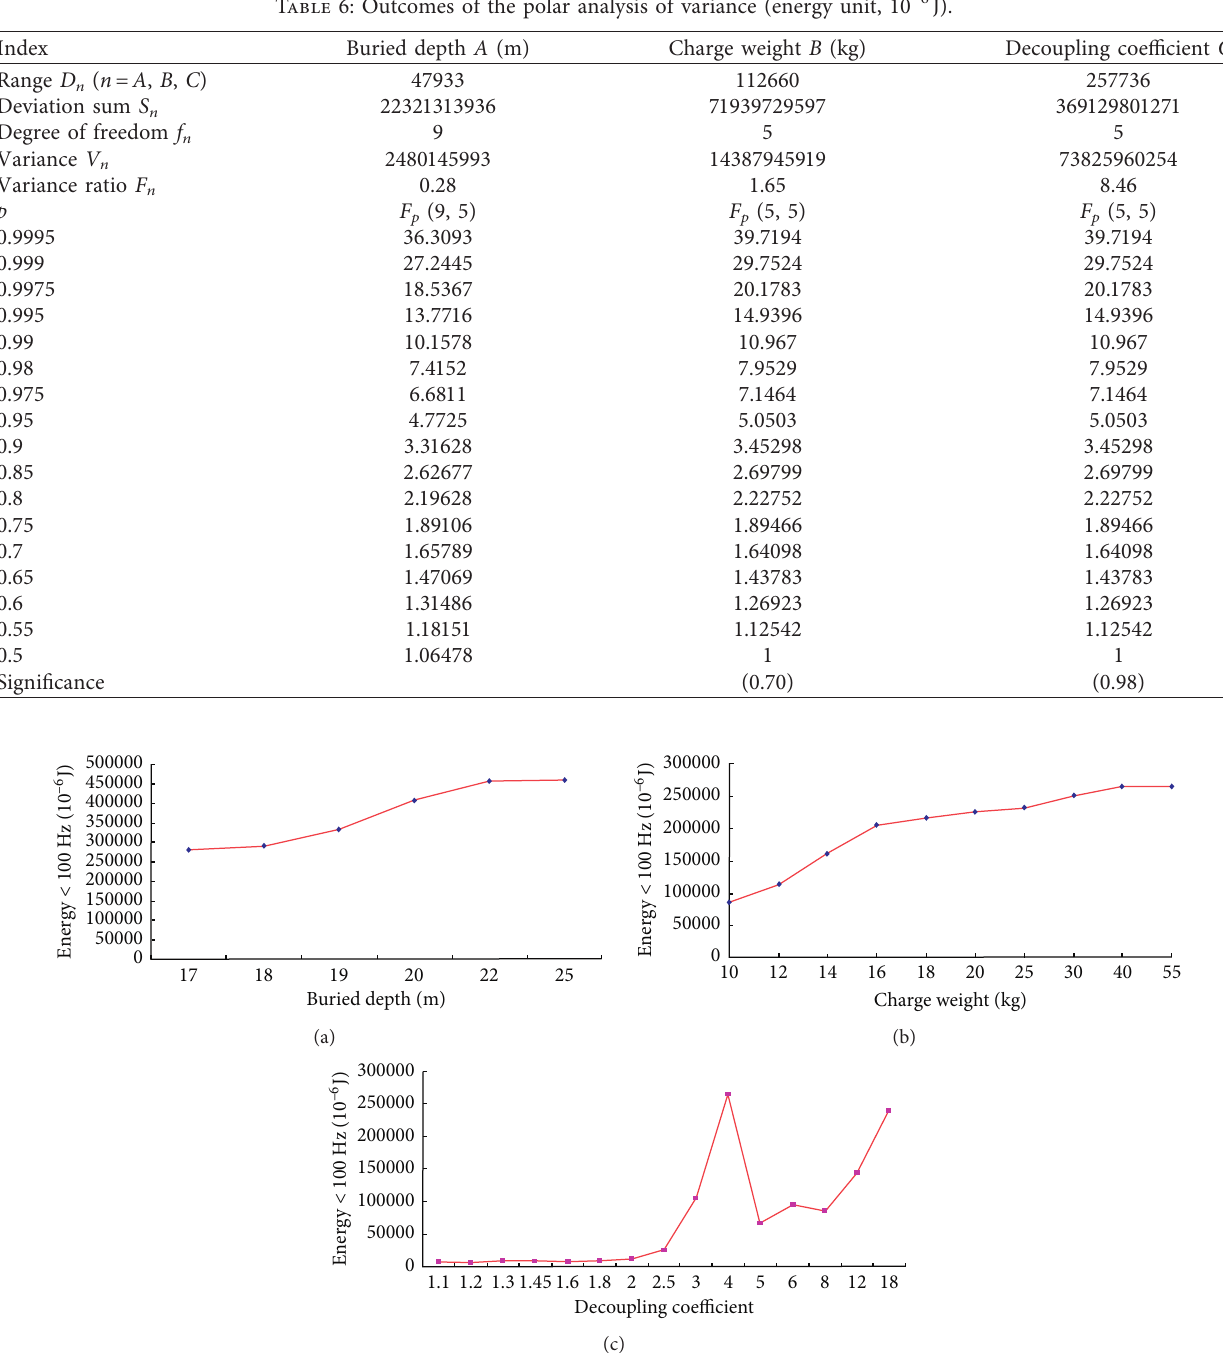
Table 6: Outcomes of the polar analysis of variance (energy unit, 10 − 6